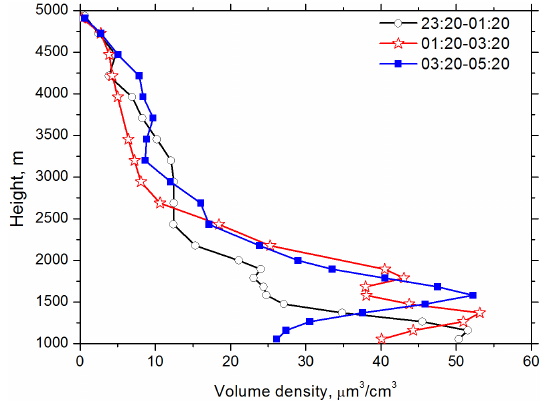
Figure 13. Vertical profiles of volume density on 27–28 August for the same time intervals as in Fig. 12.